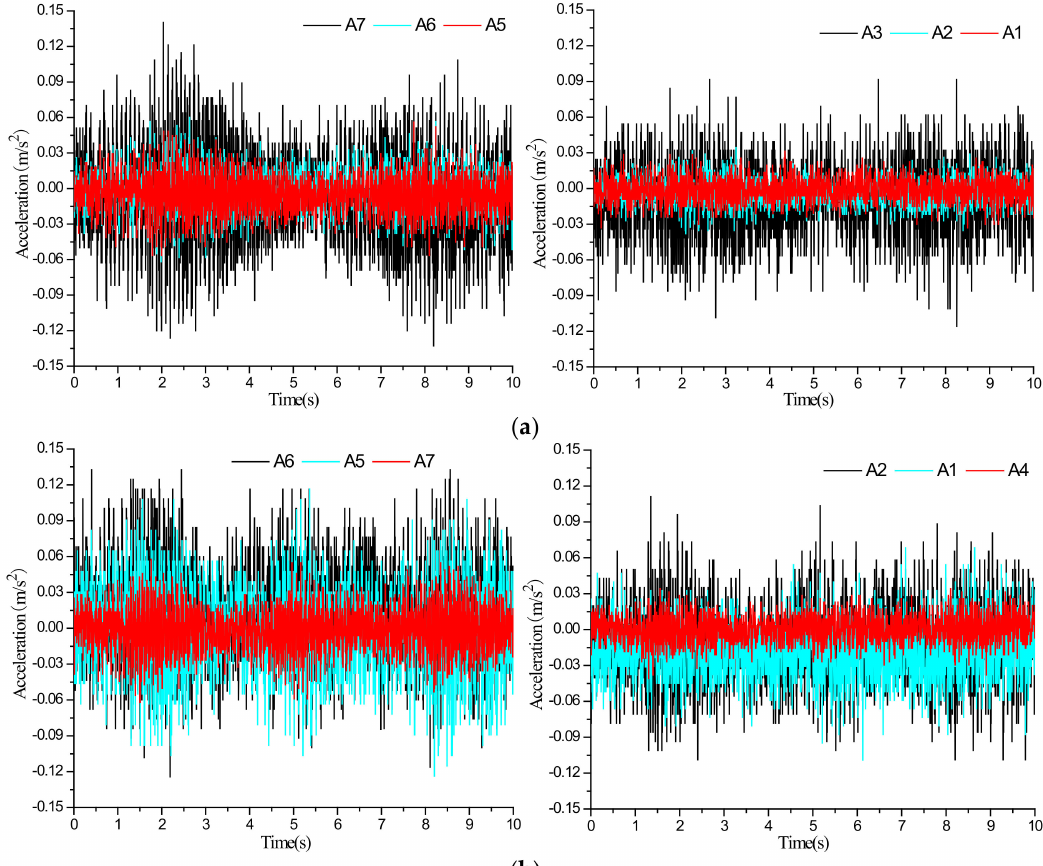
Figure 12. Acceleration time series under the combined impact of inactive ground fissure and 10 Hz excitation: ( a ) vibration exciter at 60 cm; ( b ) vibration exciter at 100